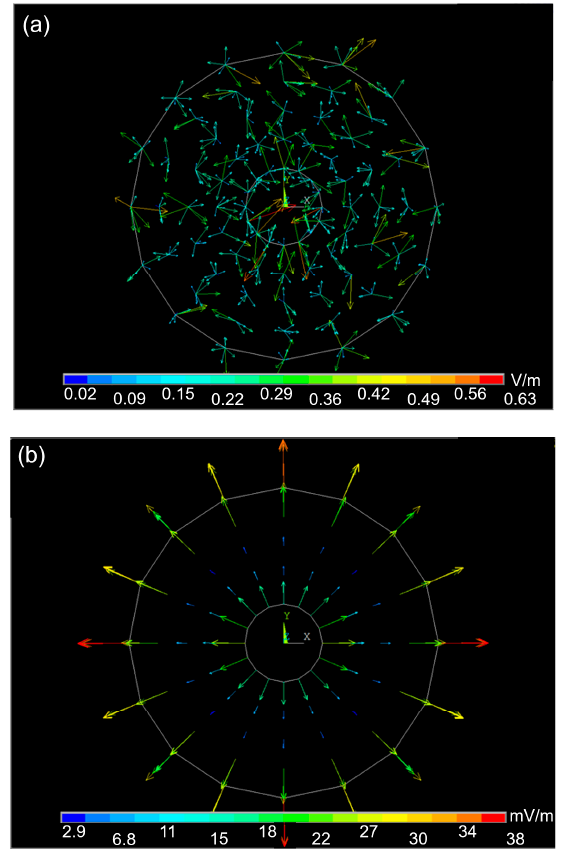
Figure 6. Direction of the electric field ( a ) before and ( b ) after the temperature decreases from the melting point to room temperature.